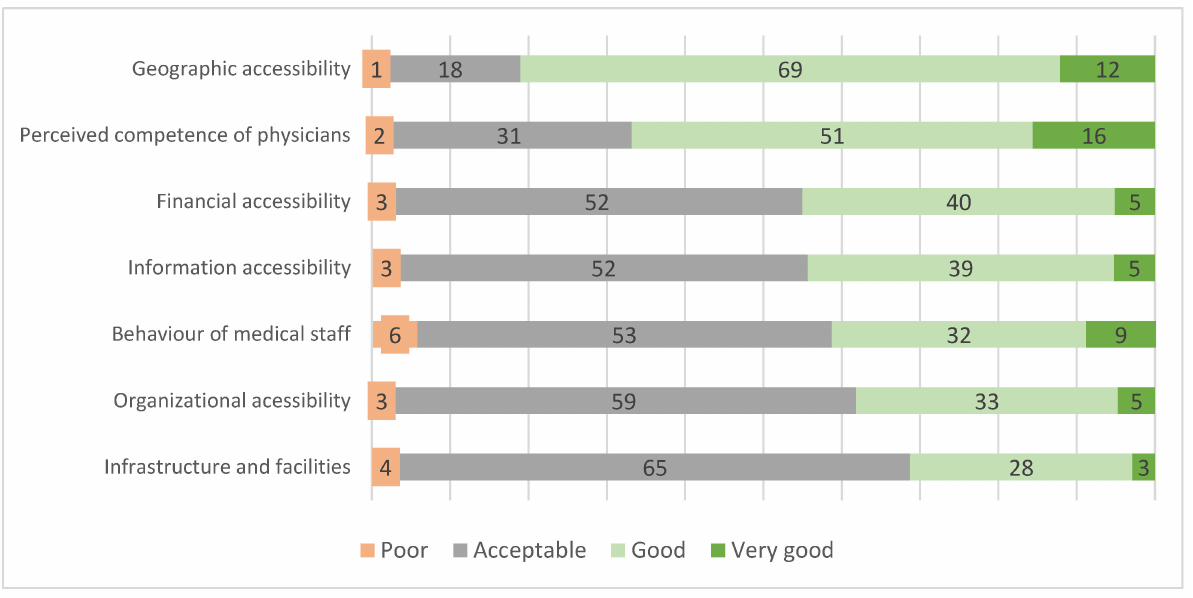
Figure 2. Assessments of determinants of PPHQ in primary healthcare (in percent of respondents, n = 1033).